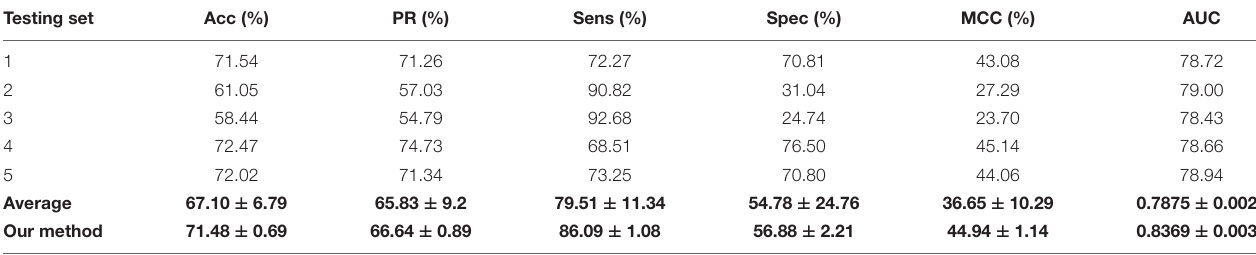
TABLE 5 | Comparison of PSSM with SMR-based method on the A. thaliana dataset. Testing set